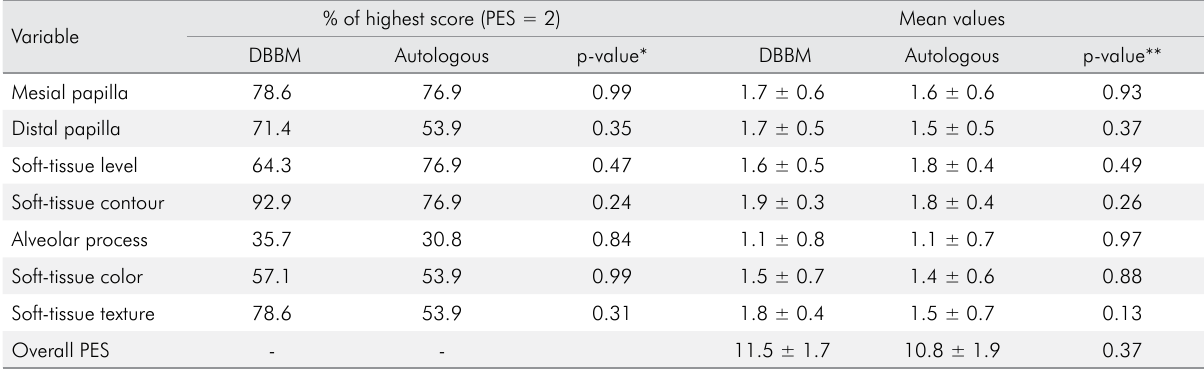
Table 4. Pink esthetic score (PES) for DBBM and autologous block groups.